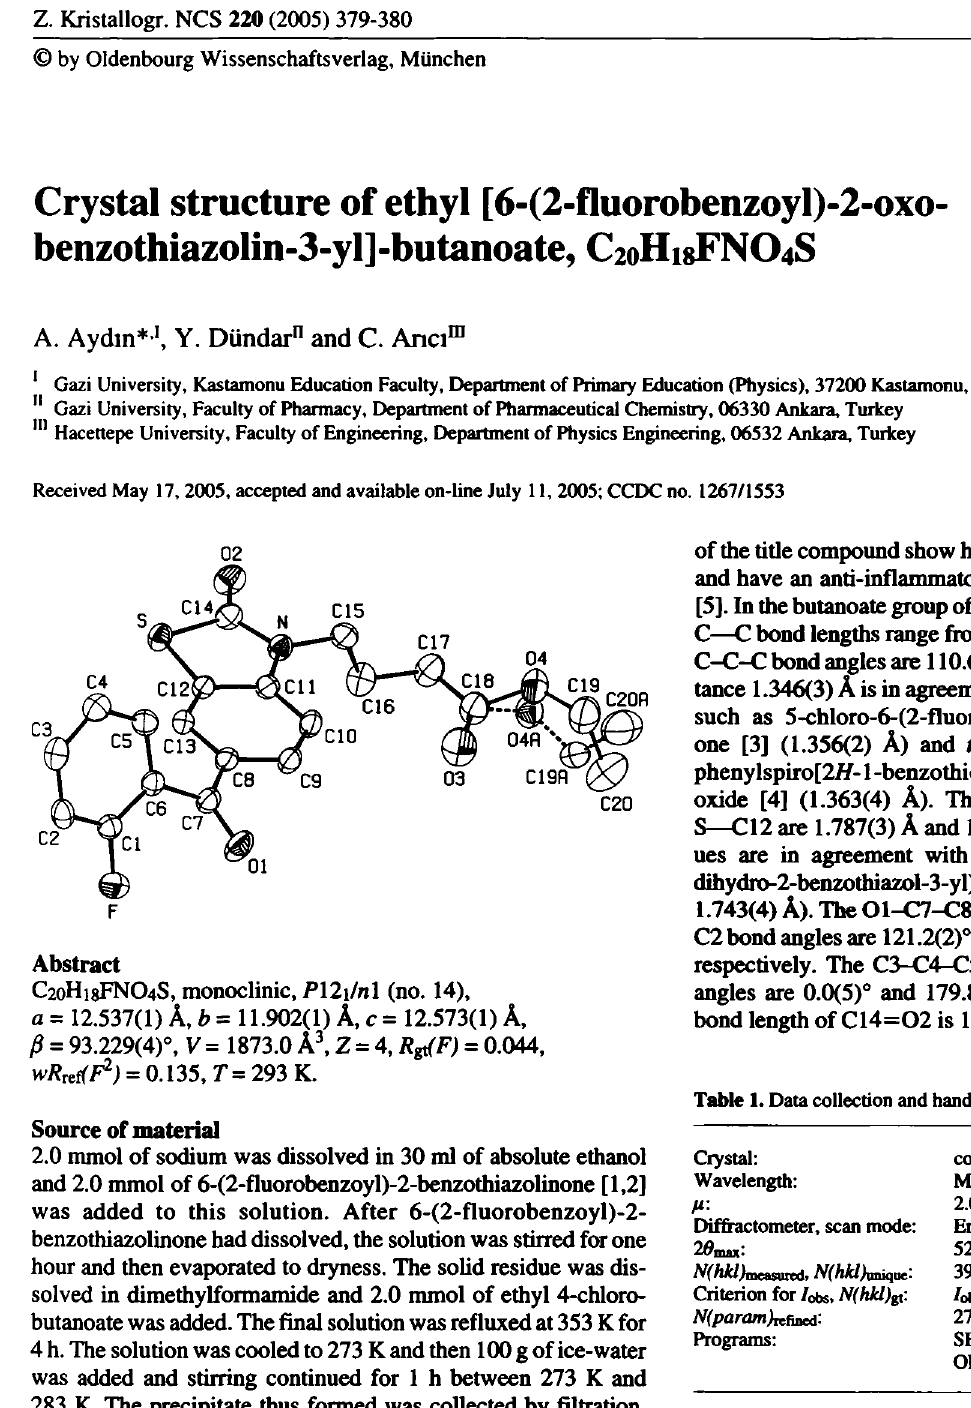
Table 2. Atomic coordinates and displacement parameters (in A 2